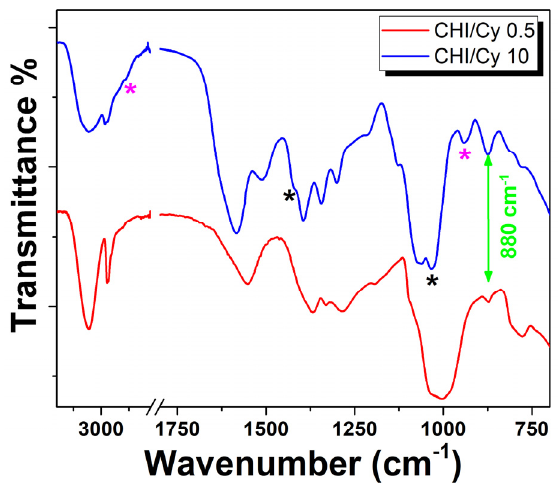
Figure 2. FTIR spectra of Cu-based alloy coated with a chitosan coating with different concentrations of cysteine: 0.5 mg/mL and 10 mg/mL, red and blue line, respectively. Pink stars show S-H group and black stars show aldehyde group.